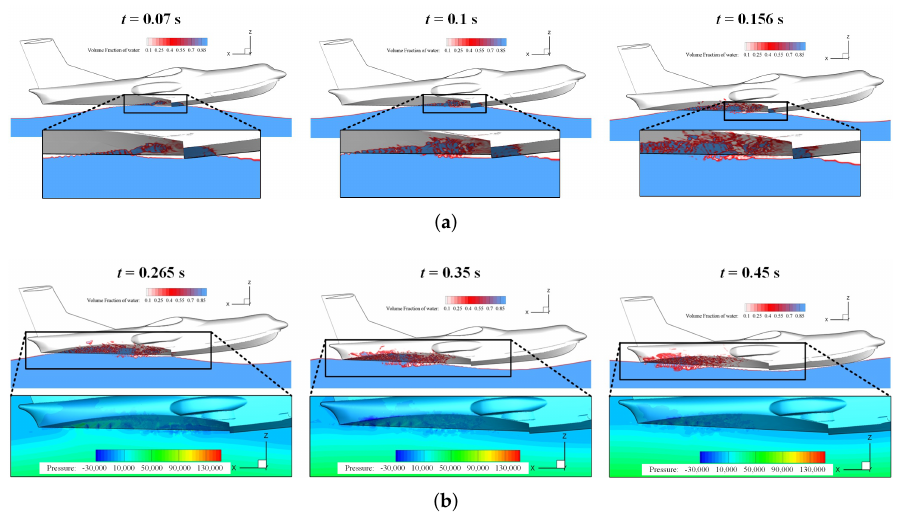
Figure 12. Time-snapshots of flowfield of aircraft landing in wave field at crest position: ( a ) air-water phase contour during the rear-fuselage impacting stage; ( b ) air-water phase contour and pressure distribution during the front-fuselage on-flight